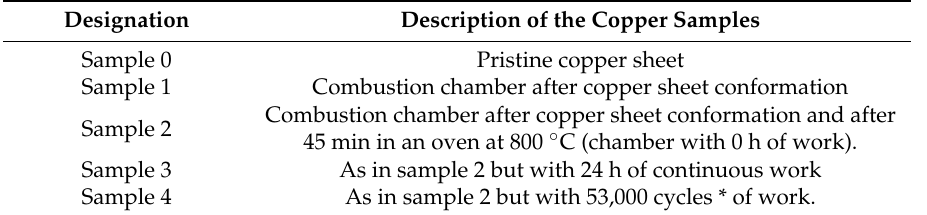
Table 1. Designation and identification of the copper used in this